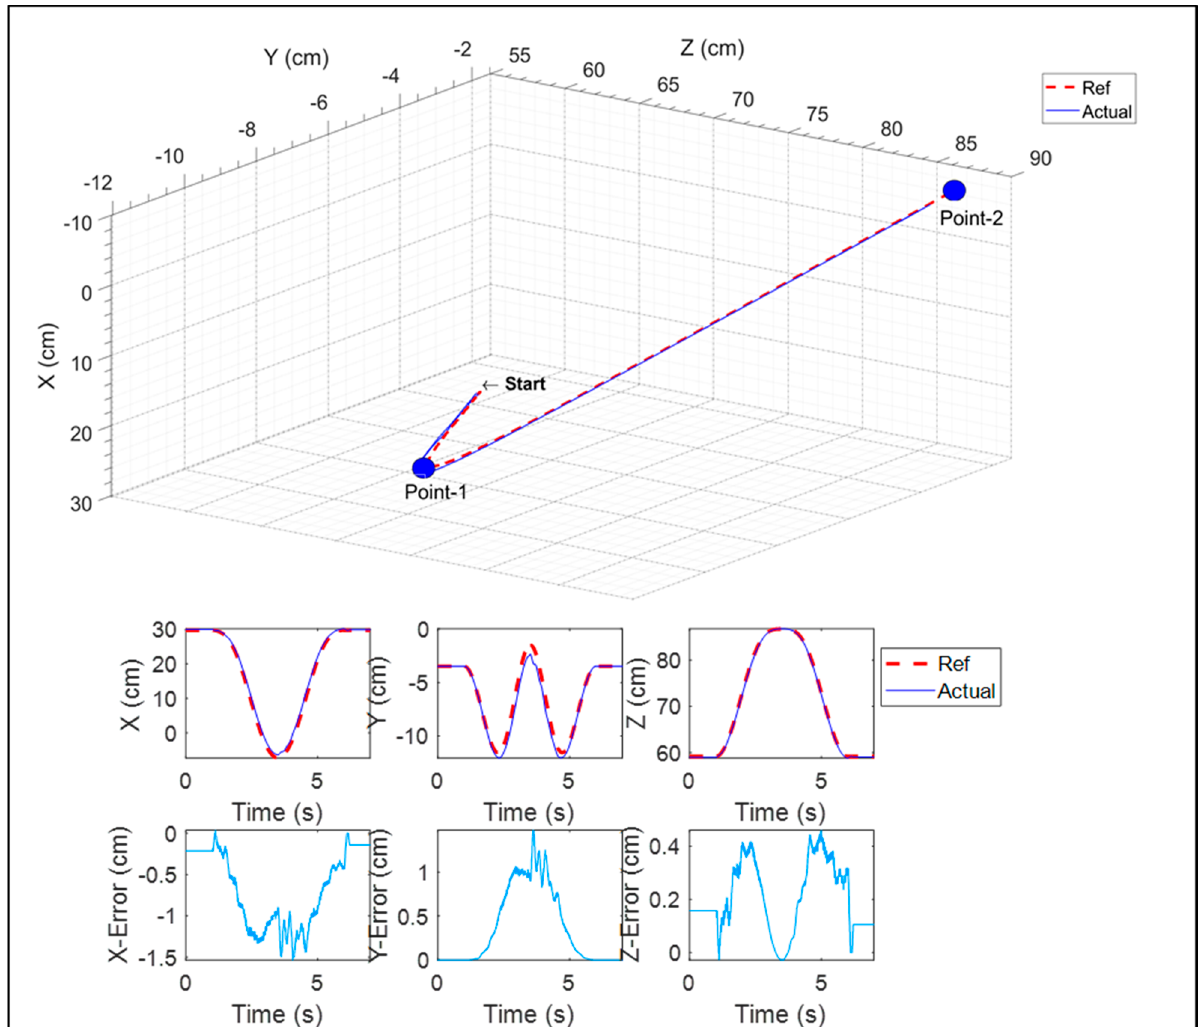
Figure 27. A 3D reaching task.